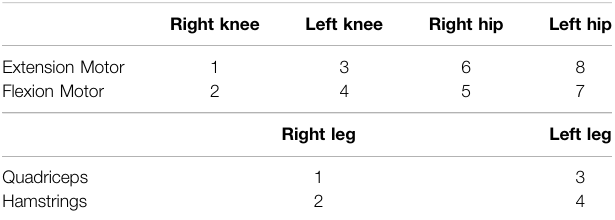
TABLE1| Flexionandextensionmotorindicesforrightandlefthipandkneejoints (top). Quadriceps and hamstrings muscles indices for right and left leg